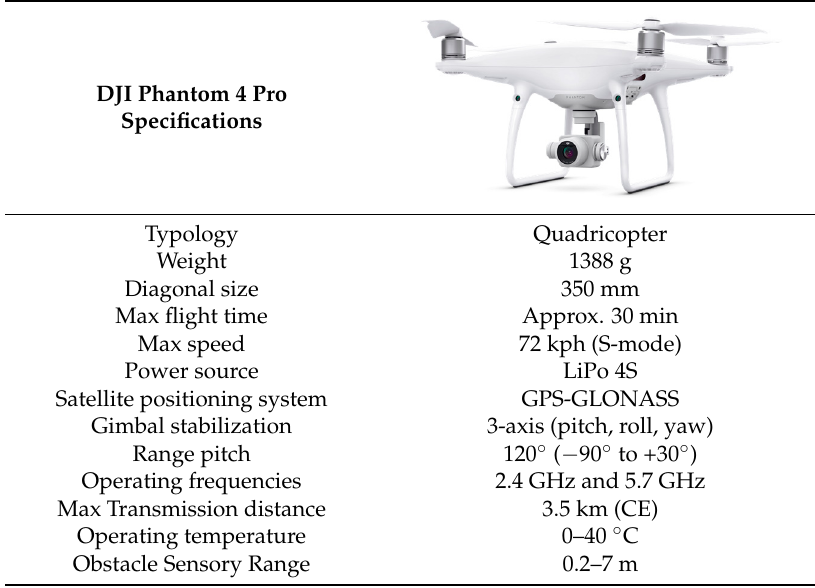
Table 1. Technical specifications of DJI Phantom 4 Pro.